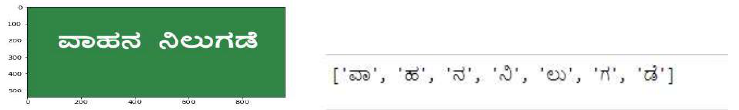
Fig. 11. Input to the training model to recognize kannada text.